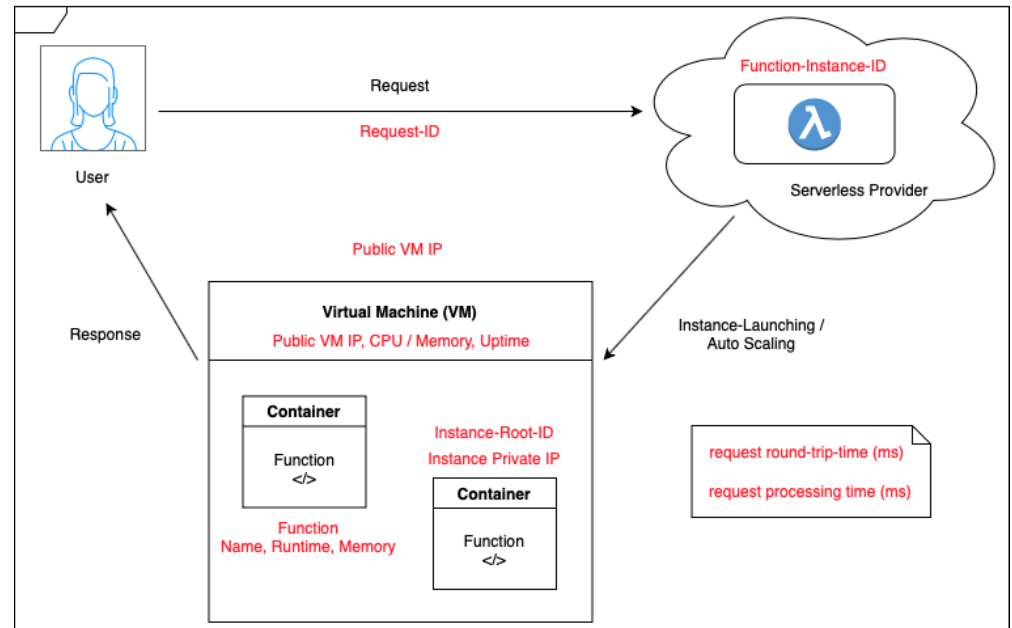
Figure 1. Overview of the typical AWS Lambda request